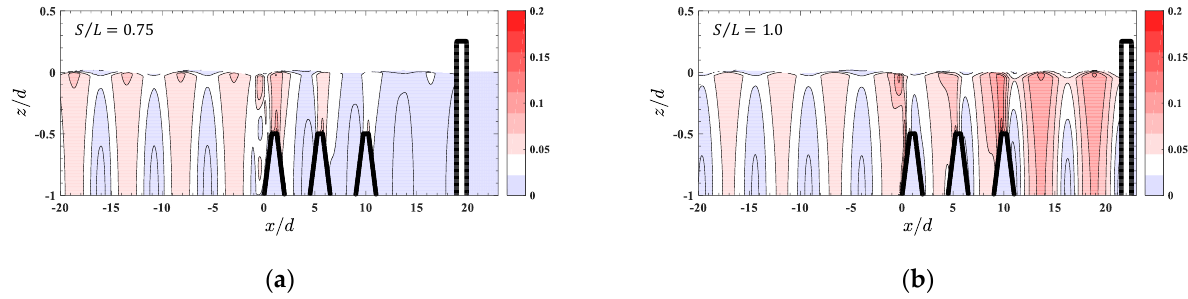
Figure 9. Distribution of the root−mean−square velocity magnitude (unit: m/s) around the breakwaters with a wave period of 𝑇 = 3.16 . ( a ) 𝑆 𝐿⁄ = 0.75 . ( b ) 𝑆 𝐿⁄ = 1.0 .